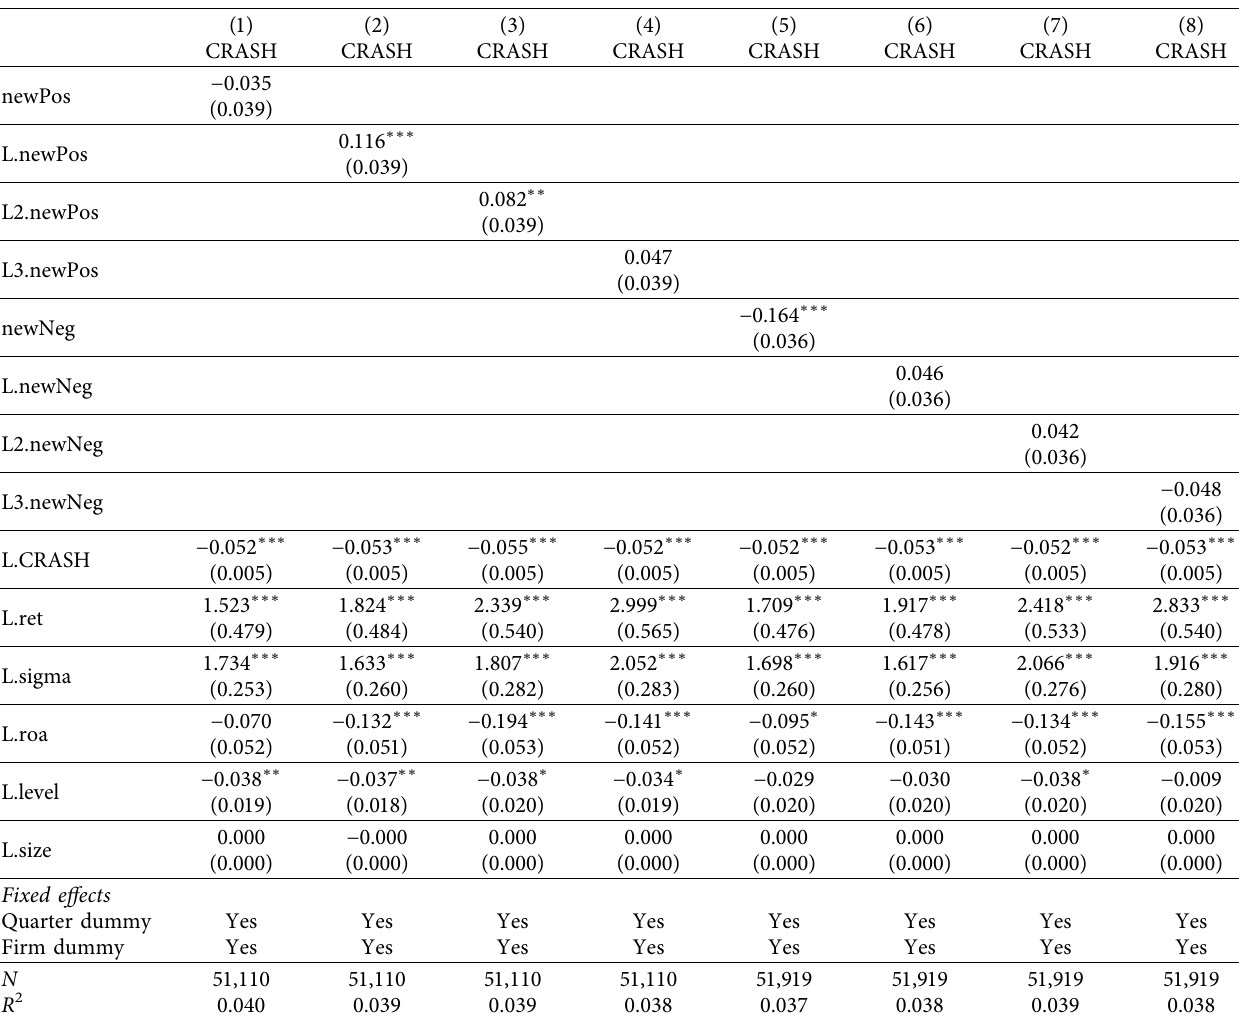
Table 6: Quarterly crash risk for different future periods.